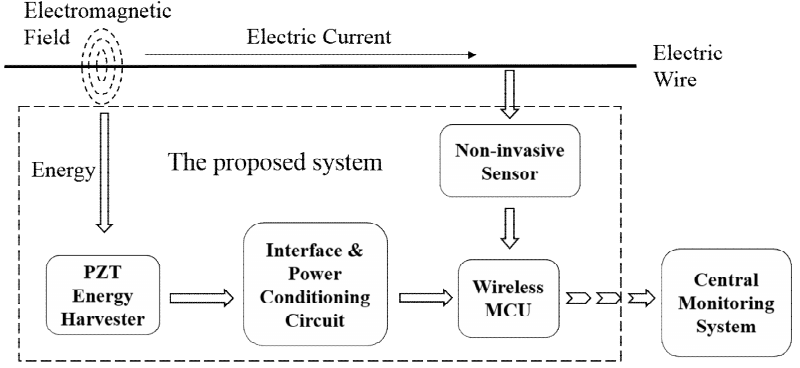
Figure 1. Overall schematic of the self-contained WSN monitoring system independent of battery.